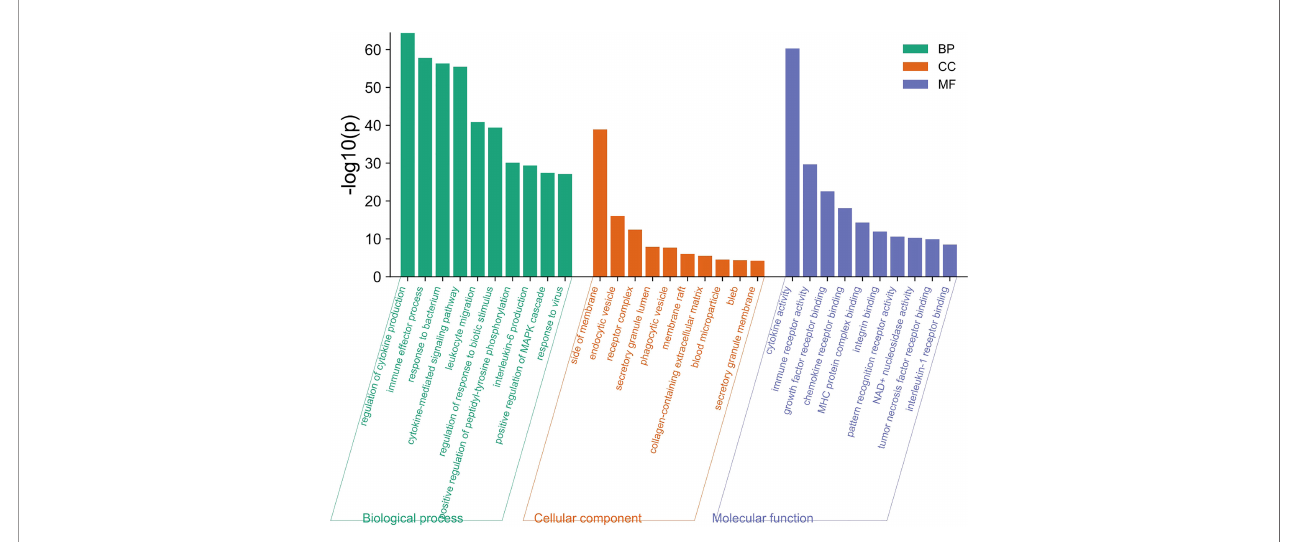
FIGURE 2 | The top 10 items of GO enrichment analysis. The green, orange, and blue bars represent the analysis results of BP, CC, and MF, respectively. “ Regulation of cytokine production ” , “ side of membrane ” , “ Cytokine activity ” were the most signi fi cant difference in BP, CC, and MF respectively.